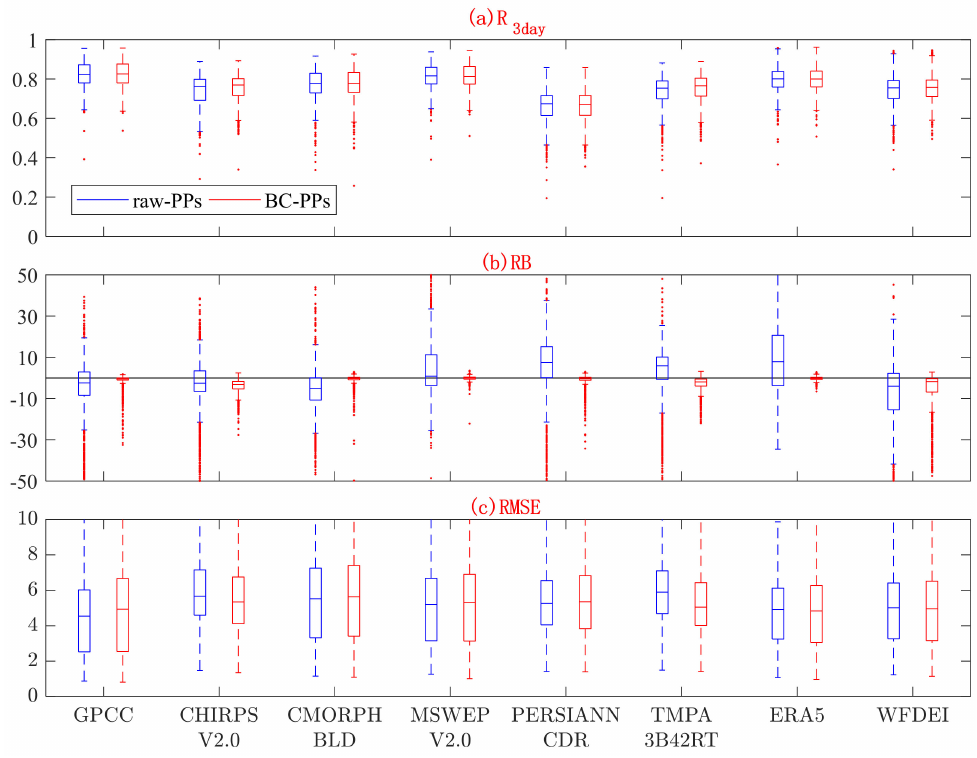
Figure 2. Boxplots of ( a ) R calculated for 3-day means (R 3day ), ( b ) RB and ( c ) RMSE for the eight PPs using gauge-observed precipitation from 1382 catchments as a reference. The circles represent the median value, and the left and right edges of the box represent the 25th and 75th percentile values, respectively, while the “whiskers” represent the extreme